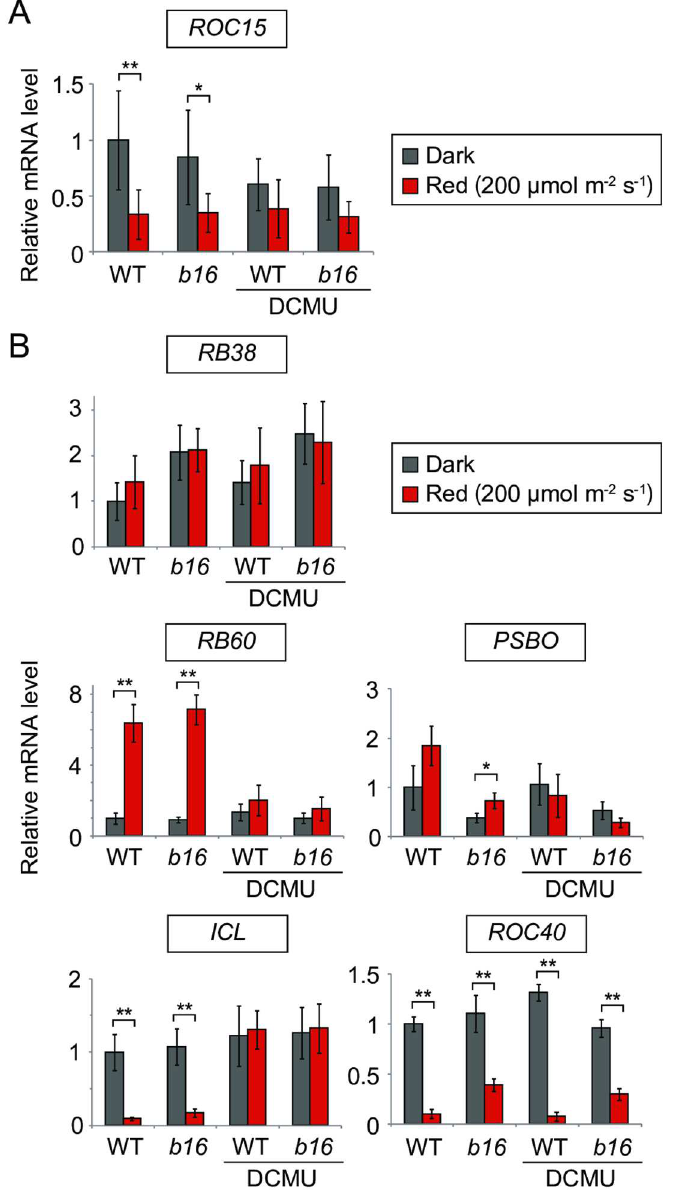
Fig 5. Red light response of ROC15 and other mRNAs. Early log phase TAP liquidcultures (approximately 5 x 10 5 cells/mL) of WT and b16 were adaptedto darknessfor one day, and then exposedto red light (200 μ mol (cid:1) m -2 (cid:1) s -1 ) for 2 h. DCMU was added to the cultures before dark adaptationat a final concentration of 10 μ M. (A, B) RT-qPCR result of ROC15 (A) and other genes (B). Graphs represent the mean ± SD of 3–6 independent experiments. The transcript abundances relative to RCK1 were further normalized by dividingby the averagefor the dark control of the WT for easy comparison. * P < 0.05, ** P < 0.01 (Student’s t